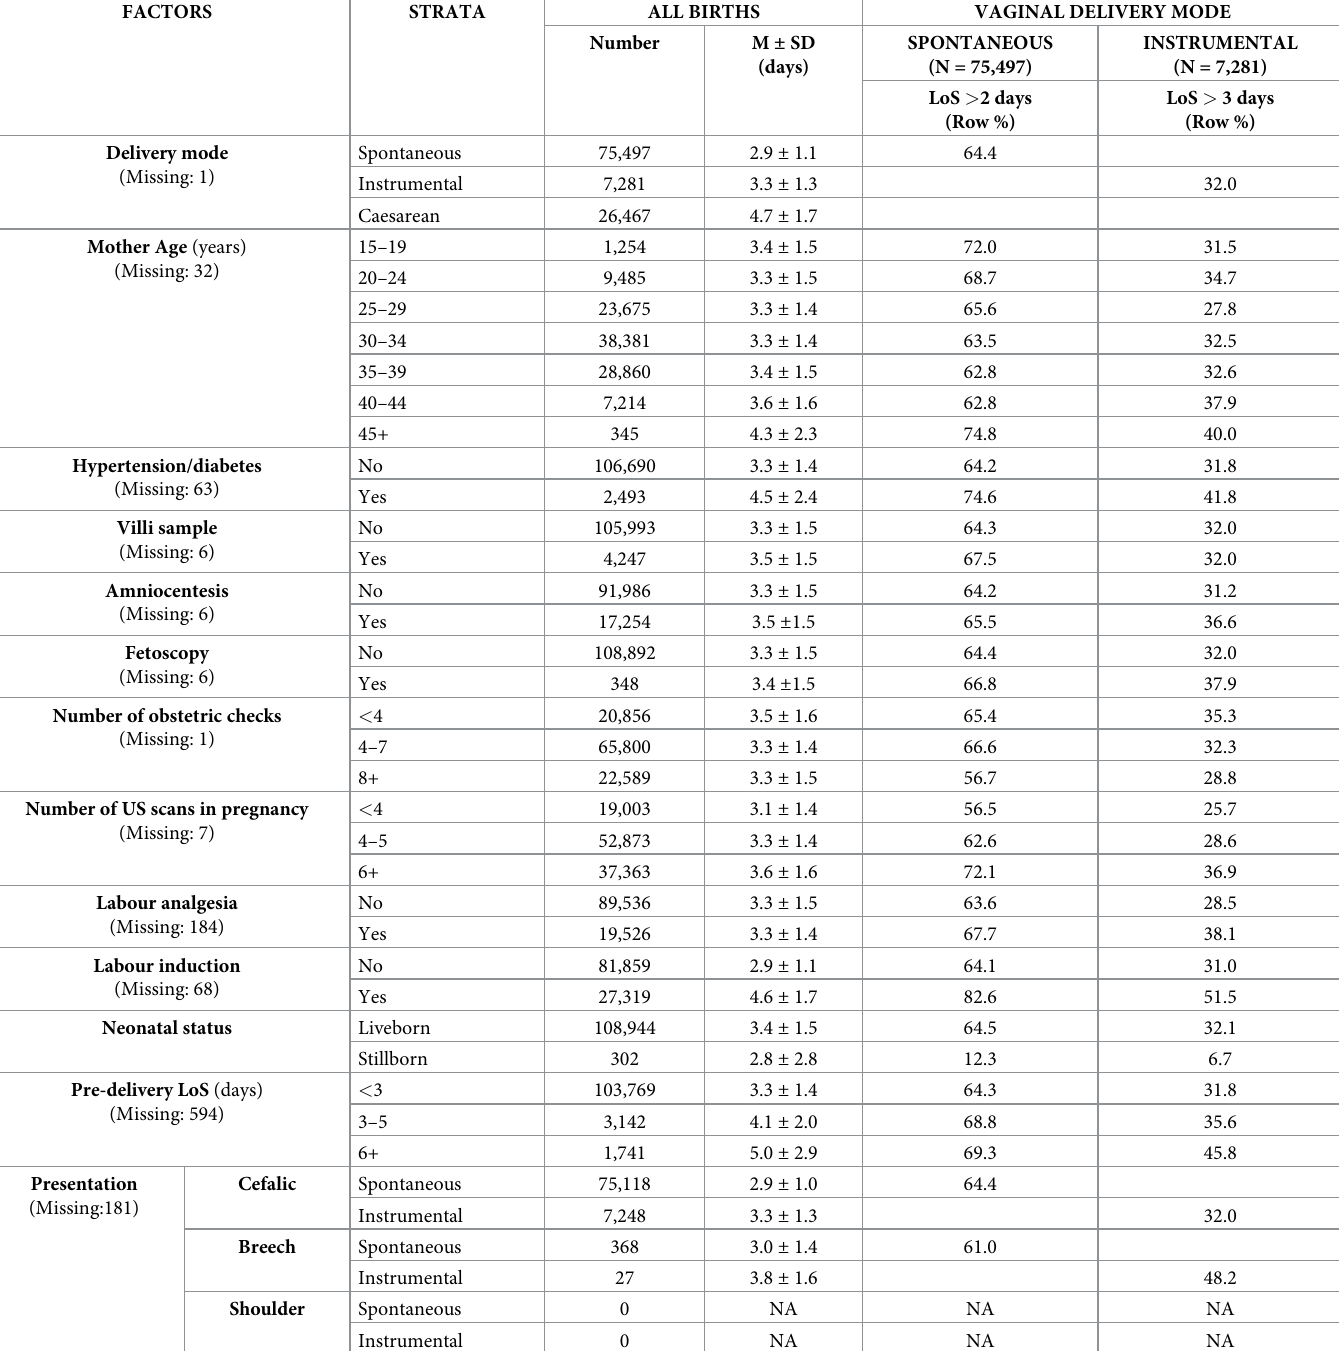
Table 2. Distribution of length of stay (LoS) after childbirth by maternal health factors. Number; mean LoS (M) ± standard deviation (SD); row percentage (row %). NA = Not applicable.